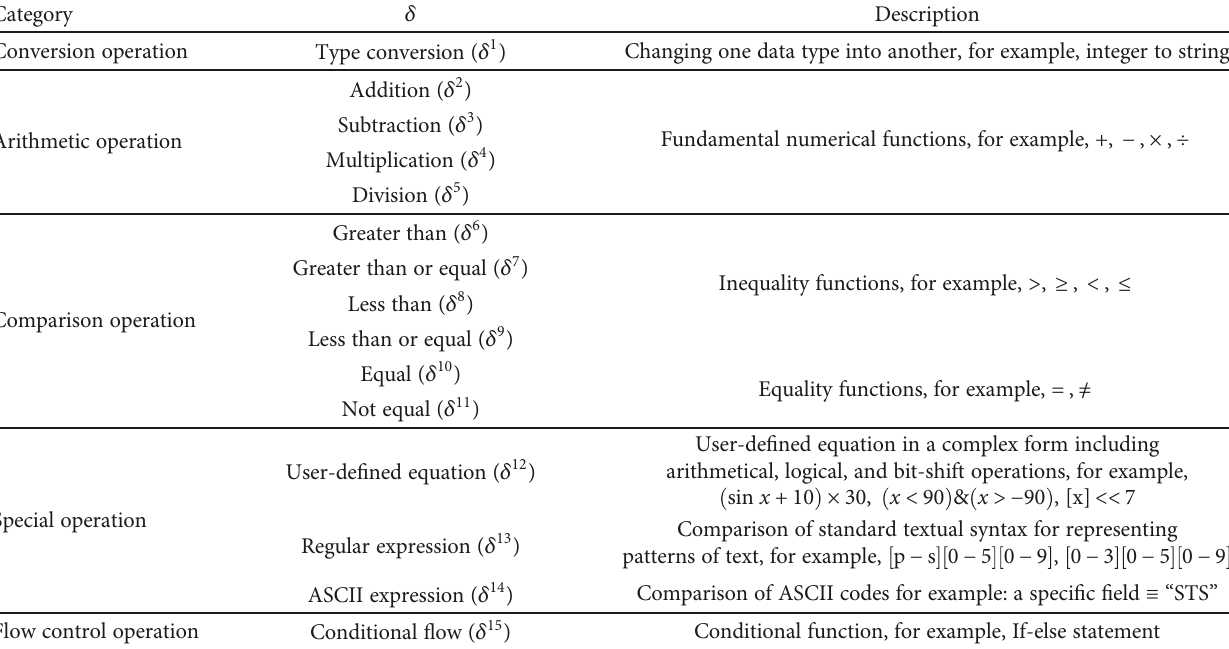
Table 4: Examples of δ classi fi ed into 5